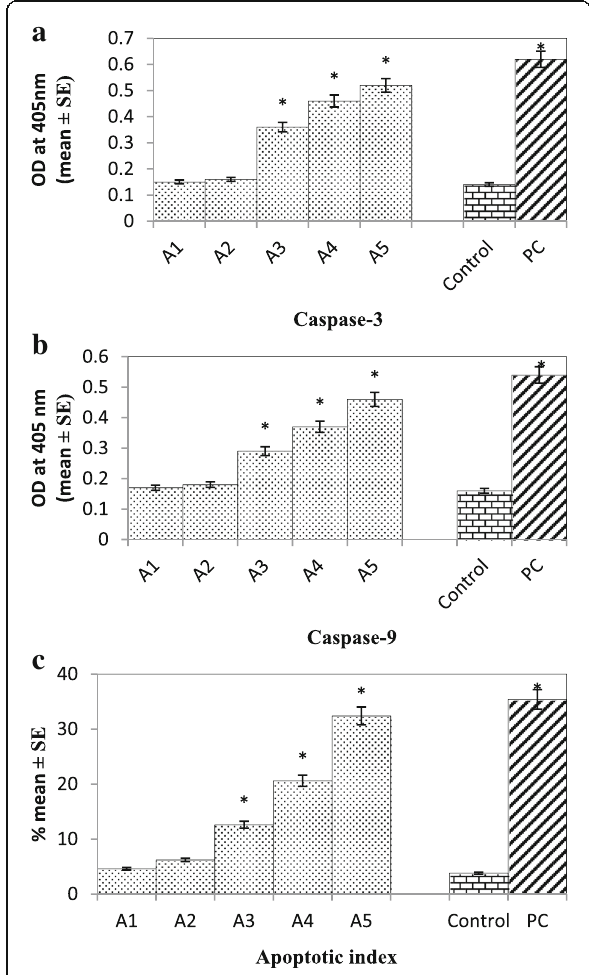
Fig. 5 Activity of caspase-3 ( a ), caspase-9 ( b ) and apoptotic index ( c ), measured in the brain cells of the flies exposed to various doses of arecoline. Arecoline (A1= 5 μ M arecoline, A2 = 10 μ M arecoline, A3 = 20 μ M arecoline, A4 = 40 μ M arecoline, A5 = 80 μ M arecoline, PC = 10 μ l/ml methyl methanesulphonate), * significant at p <